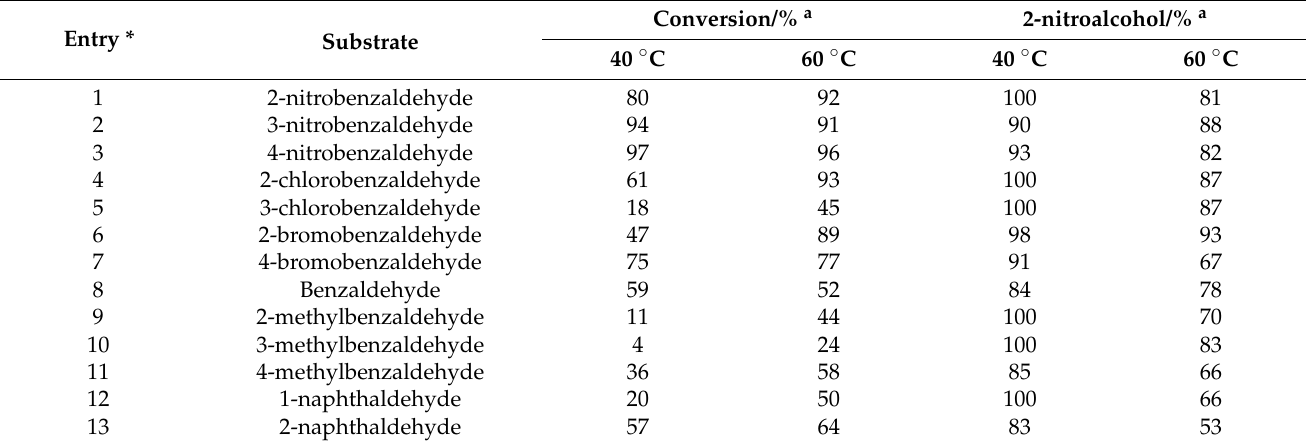
Table 7. Substrate effect on Henry reactions with nitromethane catalyzed by Cu@T-POP1.